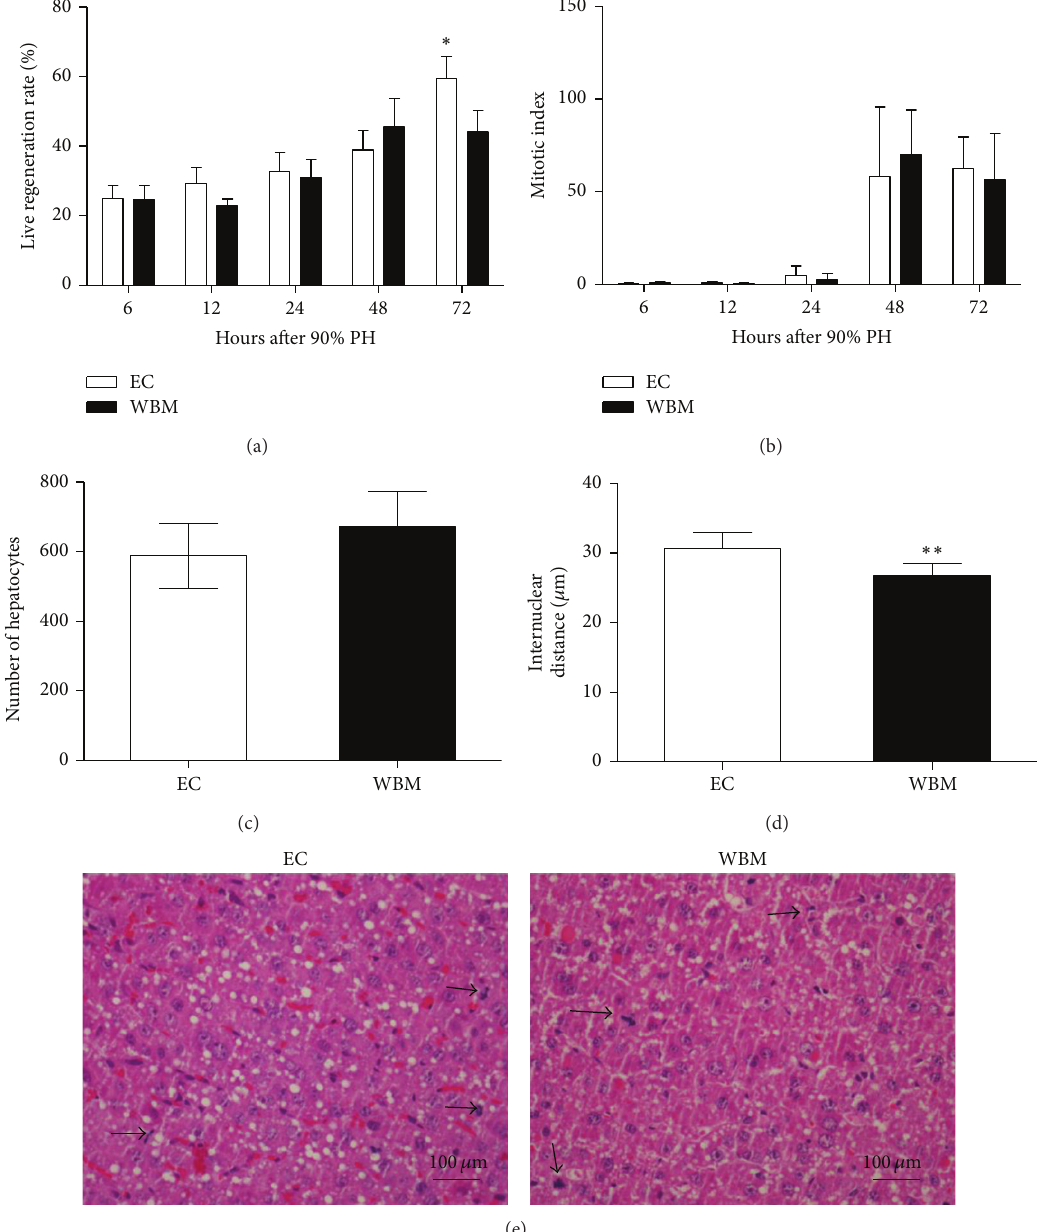
Figure 3: Liver regeneration rate after 90% partial hepatectomy (a). Mitotic index of hepatocytes after 90% partial hepatectomy (b). Number of hepatocytes (c) and internuclear distance (d) at 72 hours after partial hepatectomy. (e) Histology of mitotic hepatocytes (arrows) 72 hours after 90% partial hepatectomy; liver slides were stained with H-E. WBM: whole bone marrow; EC: empty capsules. Values are expressed as means ± SD. Student’s 𝑡 -test, ∗ 𝑃 < .05 , ∗∗ 𝑃 < .01